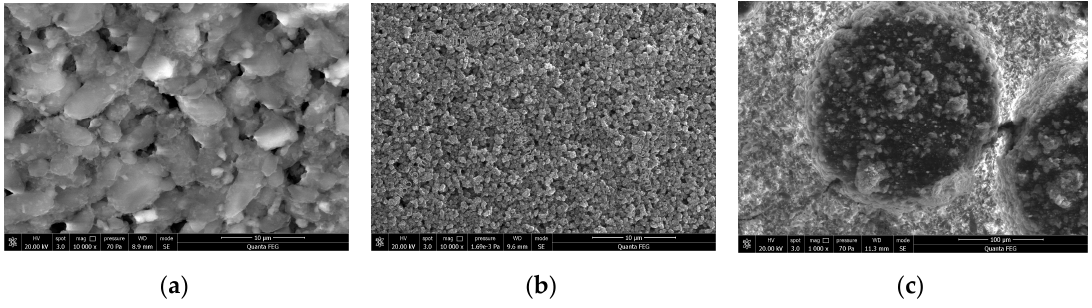
Figure 13. Through SEM: ( a ) pure fog seal; ( b ) pure titanium dioxide; ( c ) functionalized fog seal.